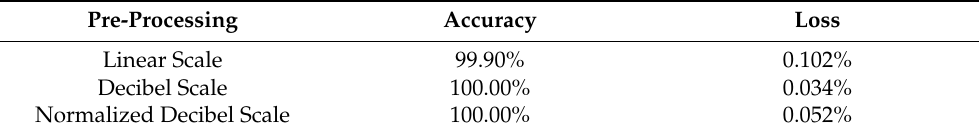
Table 6. Training results for convolutional neural network with different pre-processing methods.